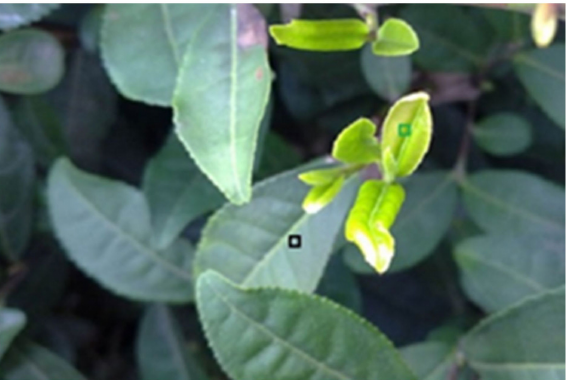
Figure 2. Selection of tender leaf area (the green box) and background area (the black